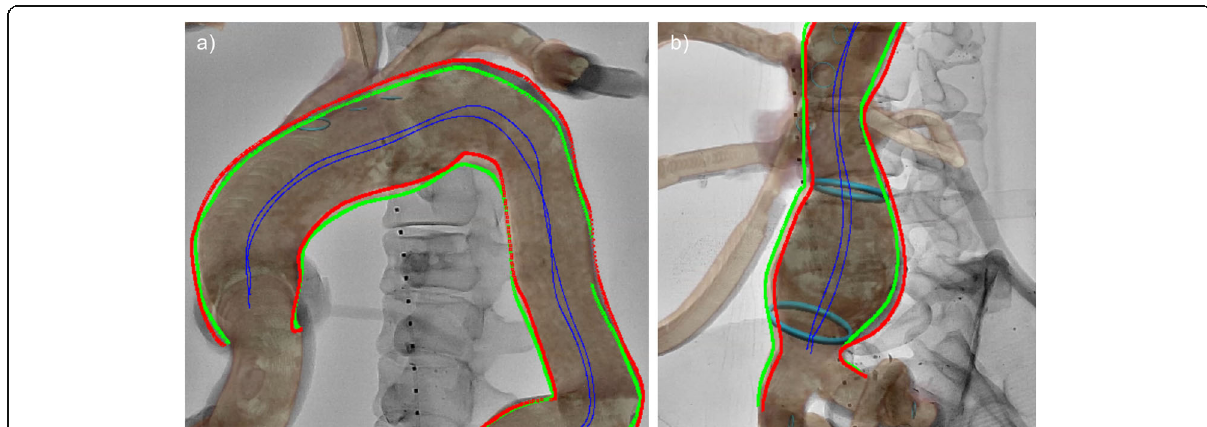
Fig. 3 Analysis of centerline deviations between the actual vessel in the phantom and the virtual 3D model, as generated from an MRA after performing FI using the 2D-3D technique in a the thorax and b the abdomen. The actual vessel ’ s borders in the fluoroscopy image (red) and the virtual model (green) were outlined manually. A MatLab tool was used to generate a centerline for each vessel and to compare deviations between both centerlines (blue) on a pixel-wise basis every 10 mm. The analysis was repeated for seven angulations of the c-arm ( − 90°, − 60°, − 30°, 0°, 30°, 60°, and 90°) in the thorax and the abdomen, respectively